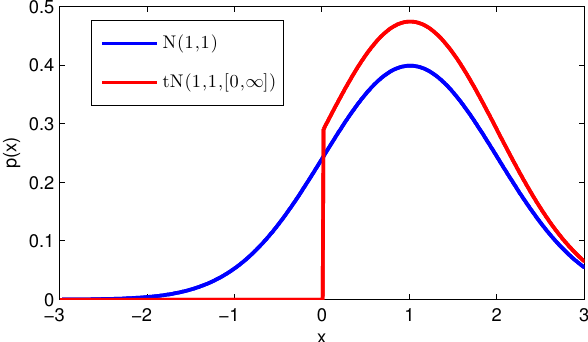
Figure 1. Example of the normal distribution N ( 1 , 1 ) , blue line, and the truncated normal distribution t N ( 1 , 1 , [ 0 , ∞] ) , red